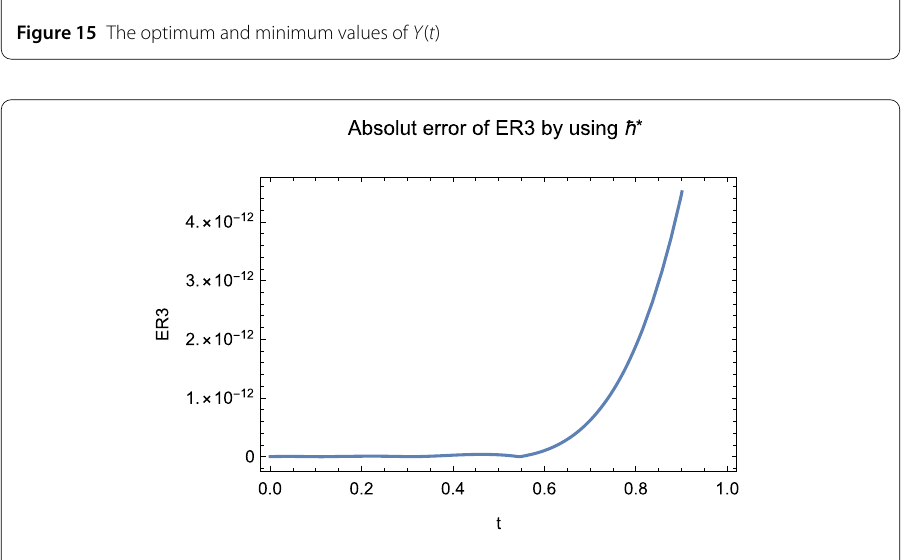
Figure 16 The optimum and minimum values of V ( t